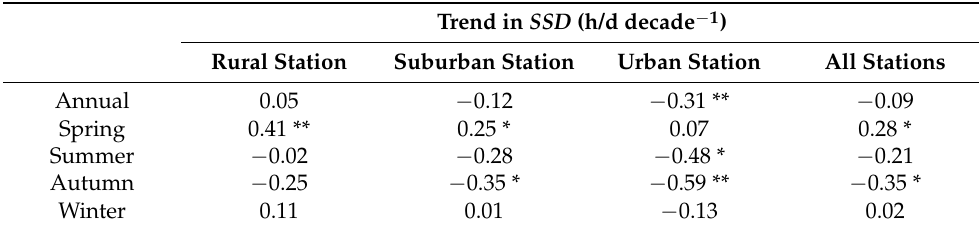
Table 2. Change trends of annual and seasonal mean sunshine duration ( SSD ) at rural, urban, and